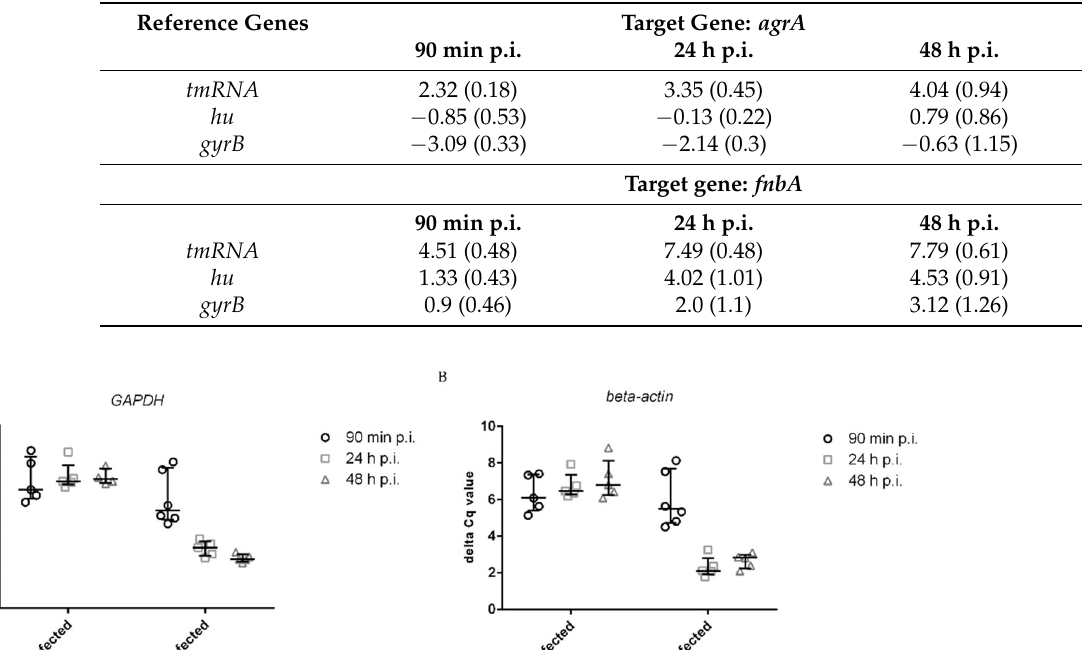
Figure 6. Variability of delta C q values of intracellular S. aureus at 90 min, 24 h, and 48 h postinfection (condition II) for each reference gene individually for ( A ) agrA and ( B ) fnbA . Bars indicate the mean of fi ve independent experiments.